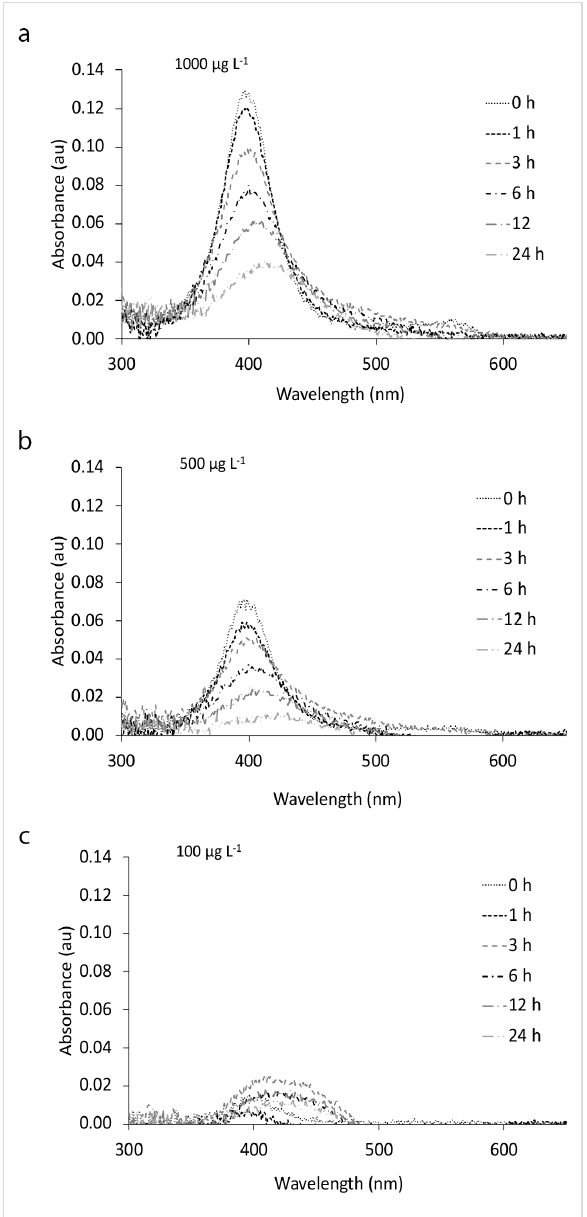
Figure 2: Behavior of PVP-AgNPs in RPMI medium during 24 h of exposure. UV–vis spectra of PVP-AgNPs in RPMI medium at concen- trations of (a) 1000, (b) 500, and (c) 100 µg·L − 1 as a function of the time. The lowest concentration (10 µg·L − 1 PVP-AgNP) did not show any signal due to the detection limit of the UV–vis